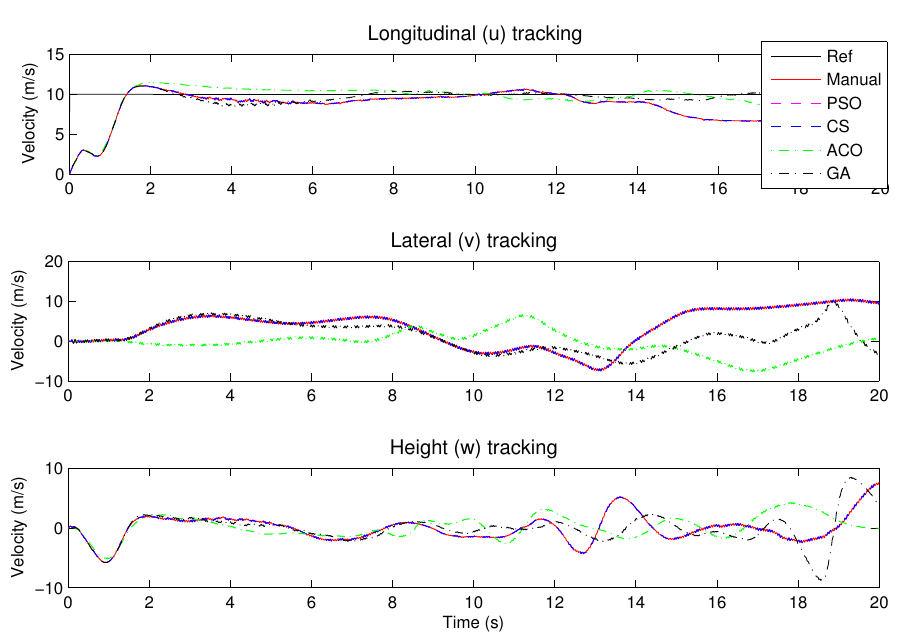
Figure 13. The nonlinear rotorcraft velocity time history 10